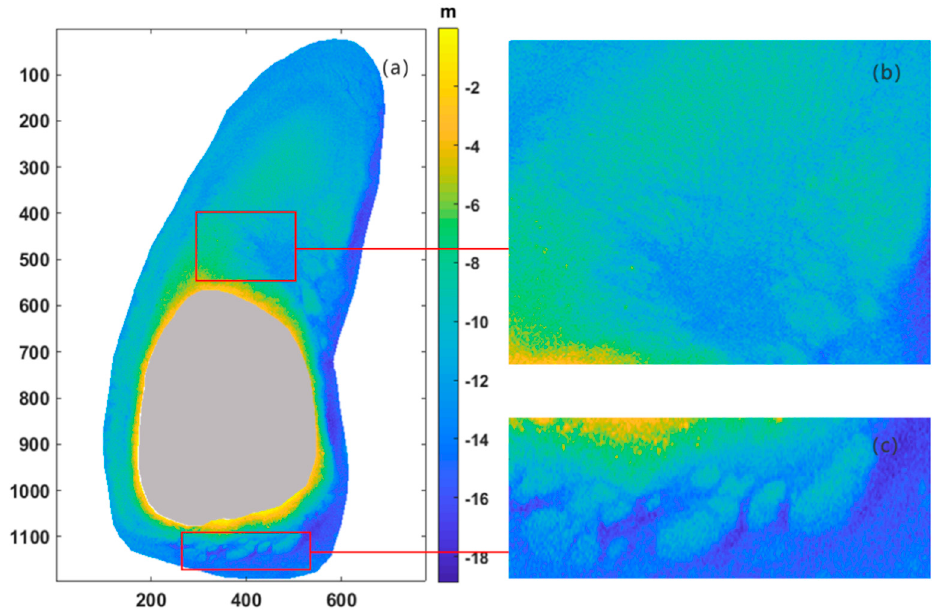
Figure 6. Bathymetric map of ( a ) Ganquan Island and ( b , c ) local details.